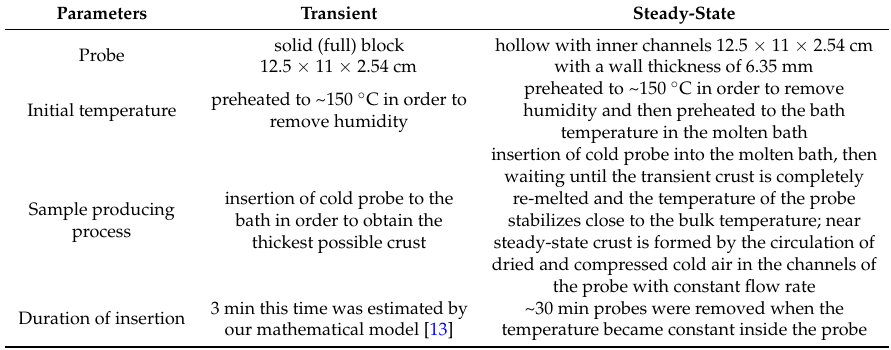
Table 1. Main characteristics of the transient and near steady-state production of